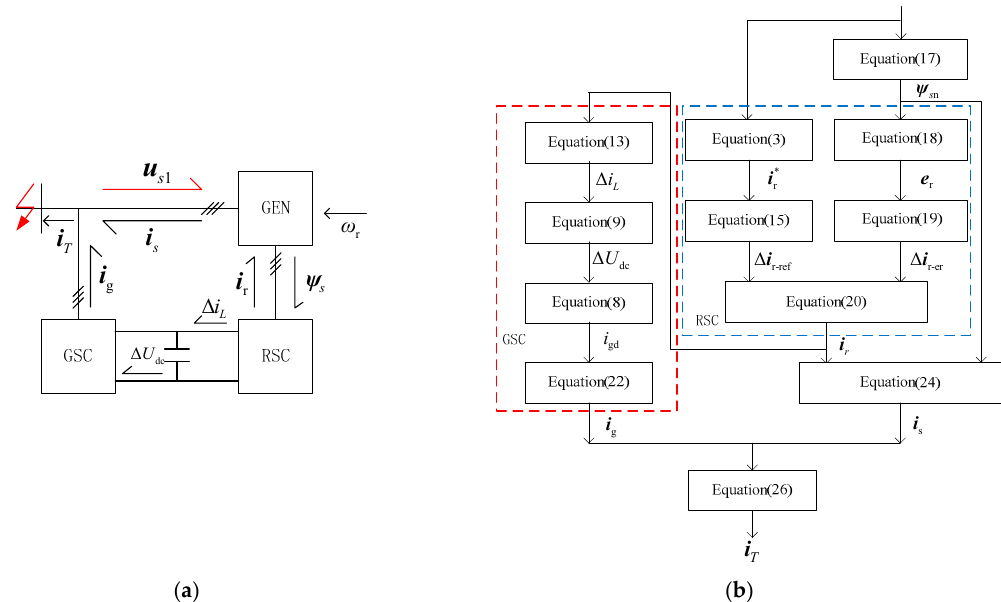
Figure 3. Flow chart of the integration process of the transient short-circuit current calculation model for DFIG-WT: ( a ) simplified graphic of the relations among critical quantities; ( b ) detailed flow chart of the integration process.